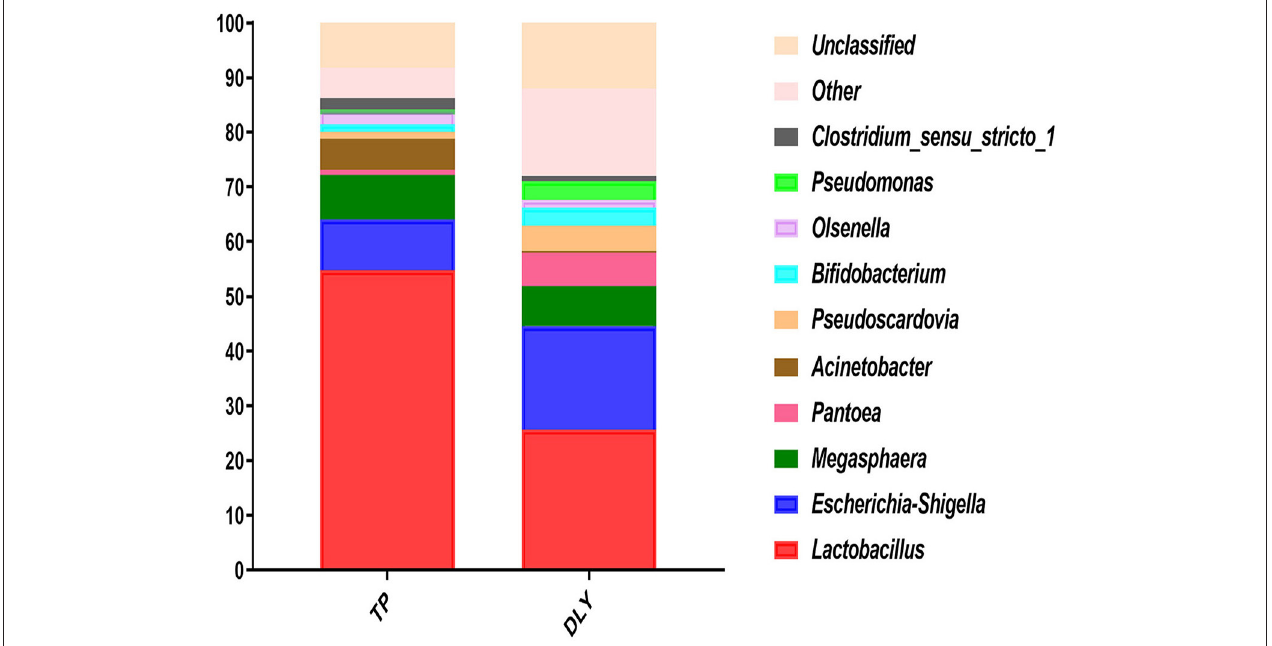
FIGURE 4 | Relative jejunal abundance at the genus level for TP and DLY pigs.